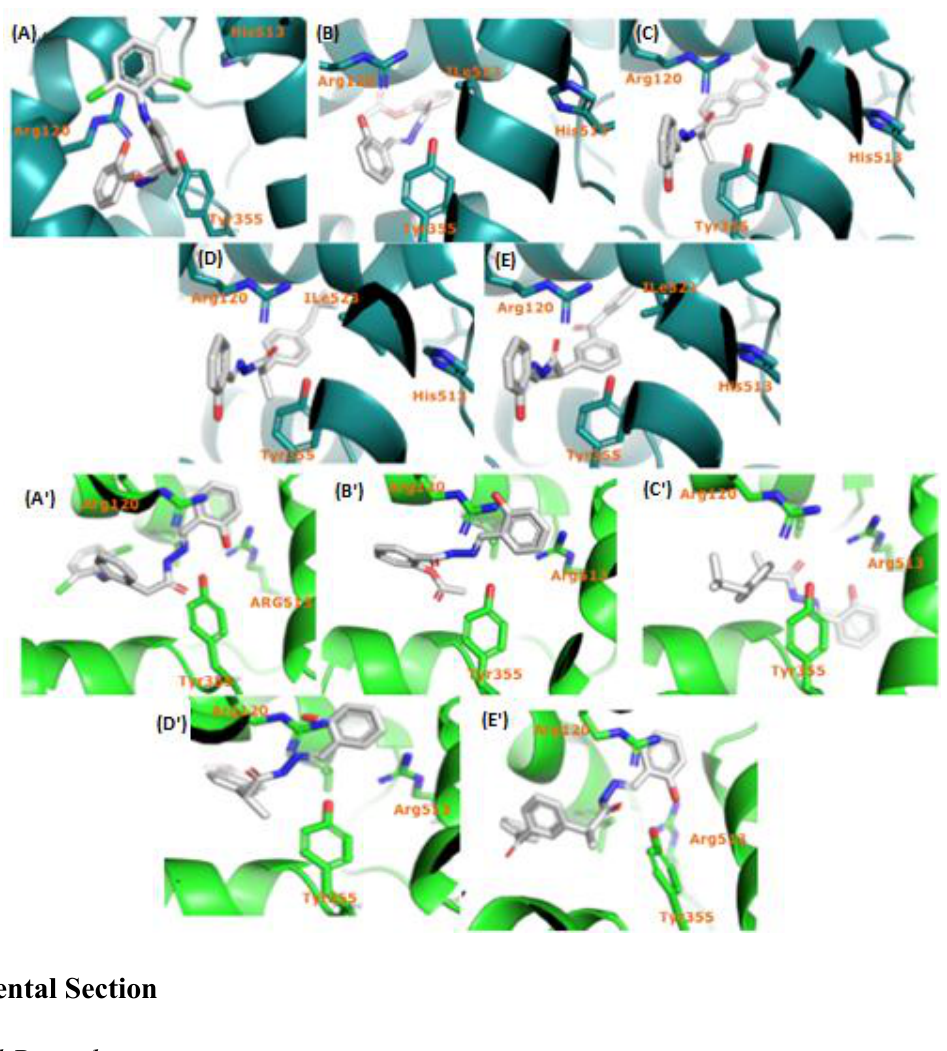
Figure 4. Results docking synthesized analogs: COX-1 blue ( A – E ) and COX-2 green ( A' – E' ). ( A ) Docking ( 4a ); ( B ) Docking ( 4b ); ( C ) Docking ( 4c ); ( D ) Docking ( 4d ) and ( E ) Docking ( 4e ) with COX-1 enzyme. ( A' ) Docking ( 4a ); ( B' ) Docking ( 4b ); ( C' ) Docking ( 4c ); ( D' ) Docking ( 4d ) and ( E' ) Docking ( 4e ) with COX-2